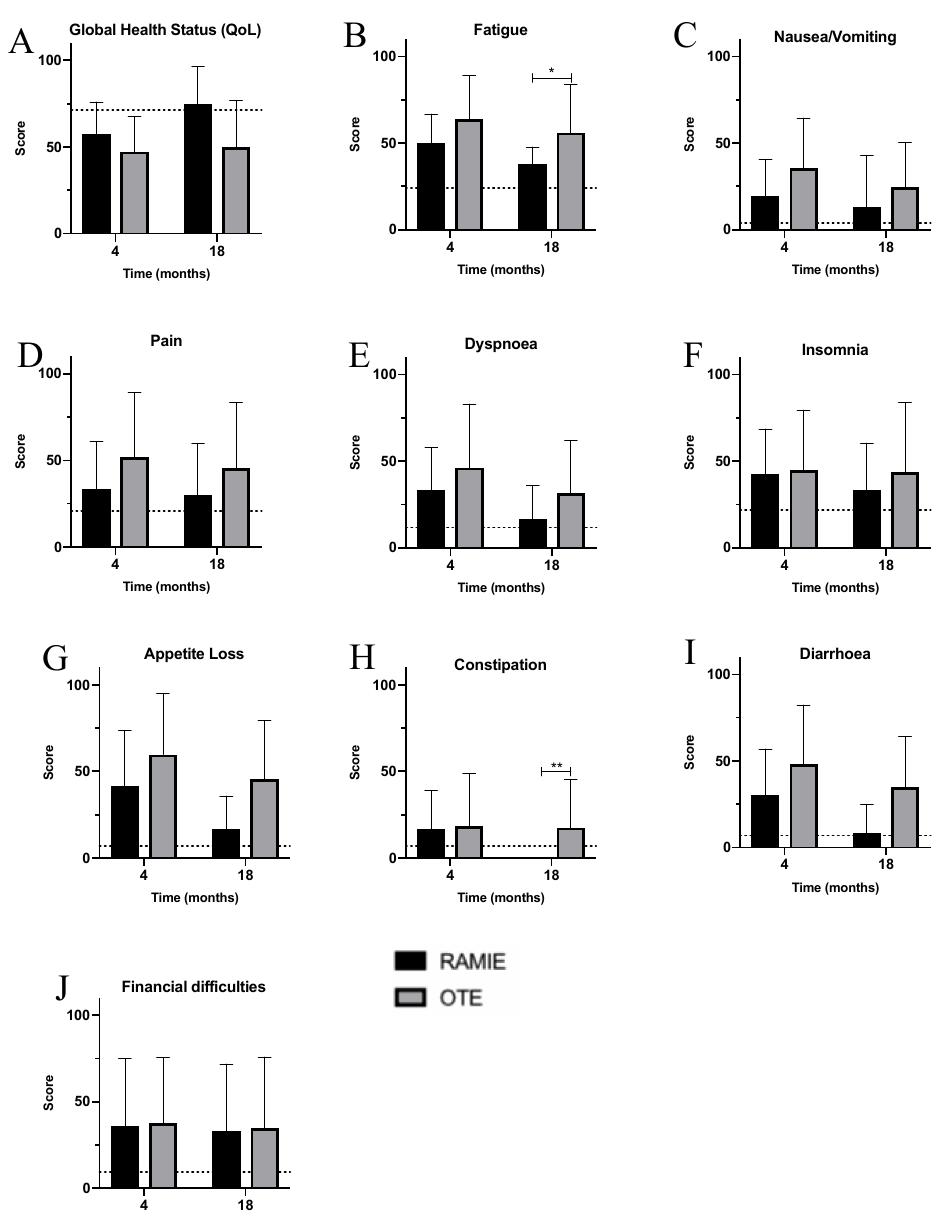
Figure 3. Quality of life and symptoms stratified by cohorts—RAMIE (black) vs. OTE (grey). ( A ) Global health status; ( B ) fatigue; ( C ) nausea / vomiting; ( D ) pain; E : dyspnea; ( F ) insomnia; ( G ) appetite loss; ( H ) constipation; ( I ) diarrhea; and ( J ) financial difficulties. OTE: open transthoracic esophagectomy; RAMIE: robot ‐ assisted minimally ‐ invasive esophagectomy.